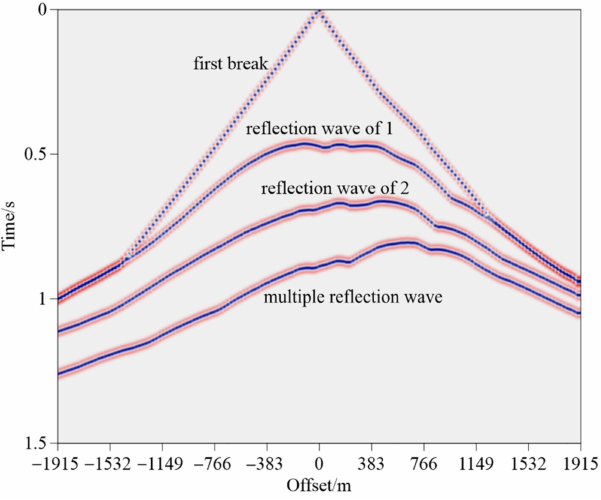
Figure 14. Synthetic seismic